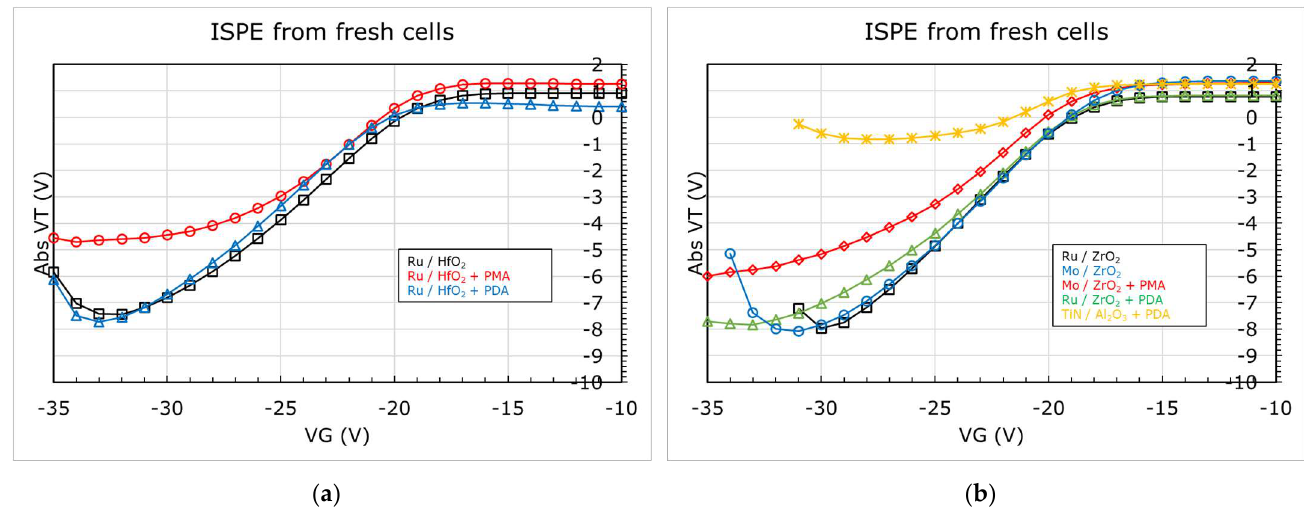
Figure 13. ISPE of MHONOS stacks for ( a ) Ru/HfO 2 . Erase performance degrades with post metallization anneal (PMA) while no change after a post high-k deposition anneal (PDA); ( b ) Ru and Mo with ZrO 2 and TiN with Al 2 O 3 . Similar degradation after PMA as in the case with HfO 2 . However, worse performance with Al 2 O 3